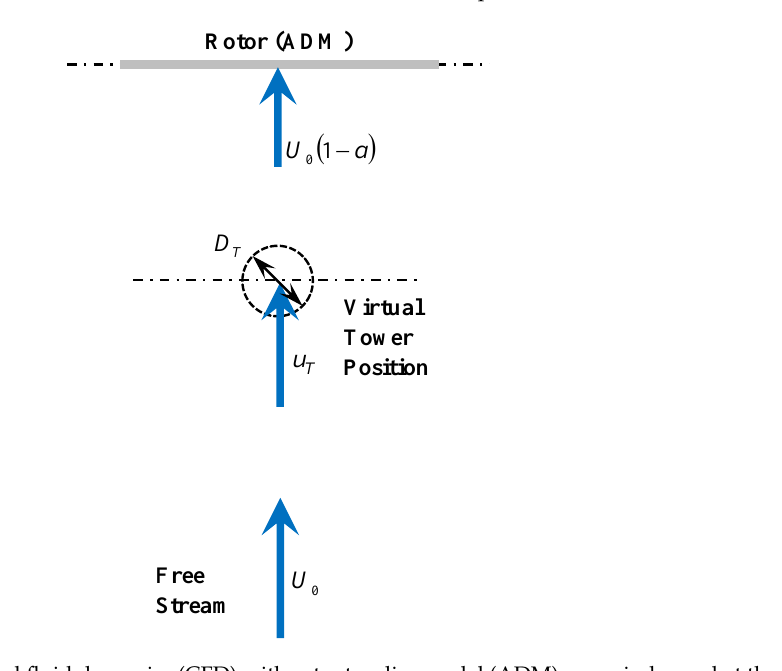
Figure 2. Computational fluid dynamics (CFD) with actuator disc model (ADM). u T , wind speed at the virtual tower position.